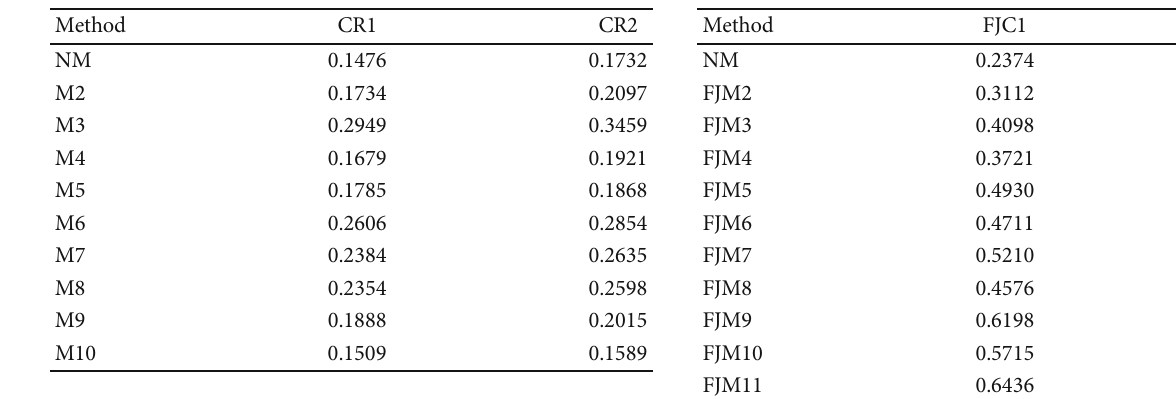
Table 16: Values of CR1 and CR2 for methods 1-10 to solve Test Problem 5, by the algorithms of the fi rst category for n = 250 .